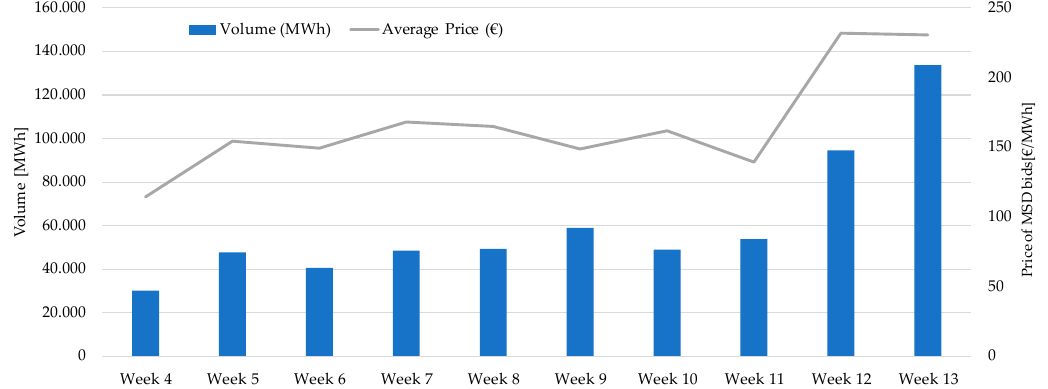
Figure 25. Weekly system costs paid by the Italian TSO in the southern Italy (CSUD) area.